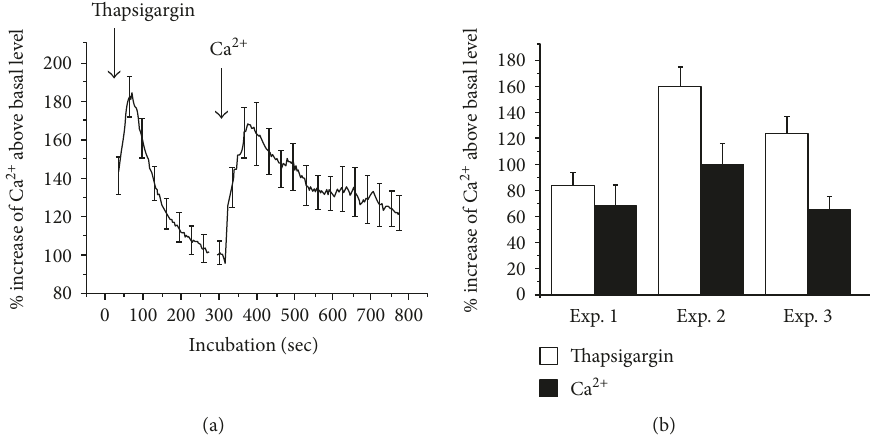
Figure 6: E ff ect of thapsigargin and calcium on proliferating stem cells incubated in a calcium-free medium. The cells were dye loaded and washed in a calcium-containing medium and then incubated in a calcium-free medium with 10 μ M EGTA. Thapsigargin (2 μ M, fi nal concentration) was added after initiation of the incubation. After incubation for 300 sec, 2mM calcium ( fi nal concentration) was added to the cells. The results from one of three independent experiments are shown (a). Abscissa: time of incubation (sec). Ordinate: intracellular calcium content. The fl uorescence intensity was normalized to the level of the fl uorescence intensity of untreated cells (100%). Mean values and SEM from 31 cells. All the cells responded to the addition of thapsigargin and calcium. Peak values from all three experiments, after addition of thapsigargin (open column) and calcium (closed column) can be seen (b). Mean values and SEM from 31 – 64 cells. Taken together, 149 cells were studied in three independent experiments, and 98% of the cells responded to the addition of both thapsigargin and